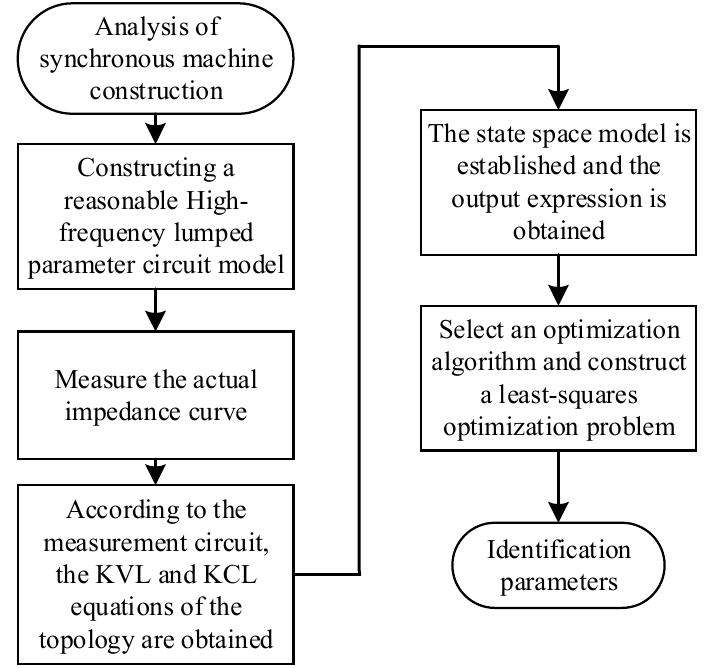
Figure 1 . Flow chart of proposed method Figure 1. Flow chart of proposed method.